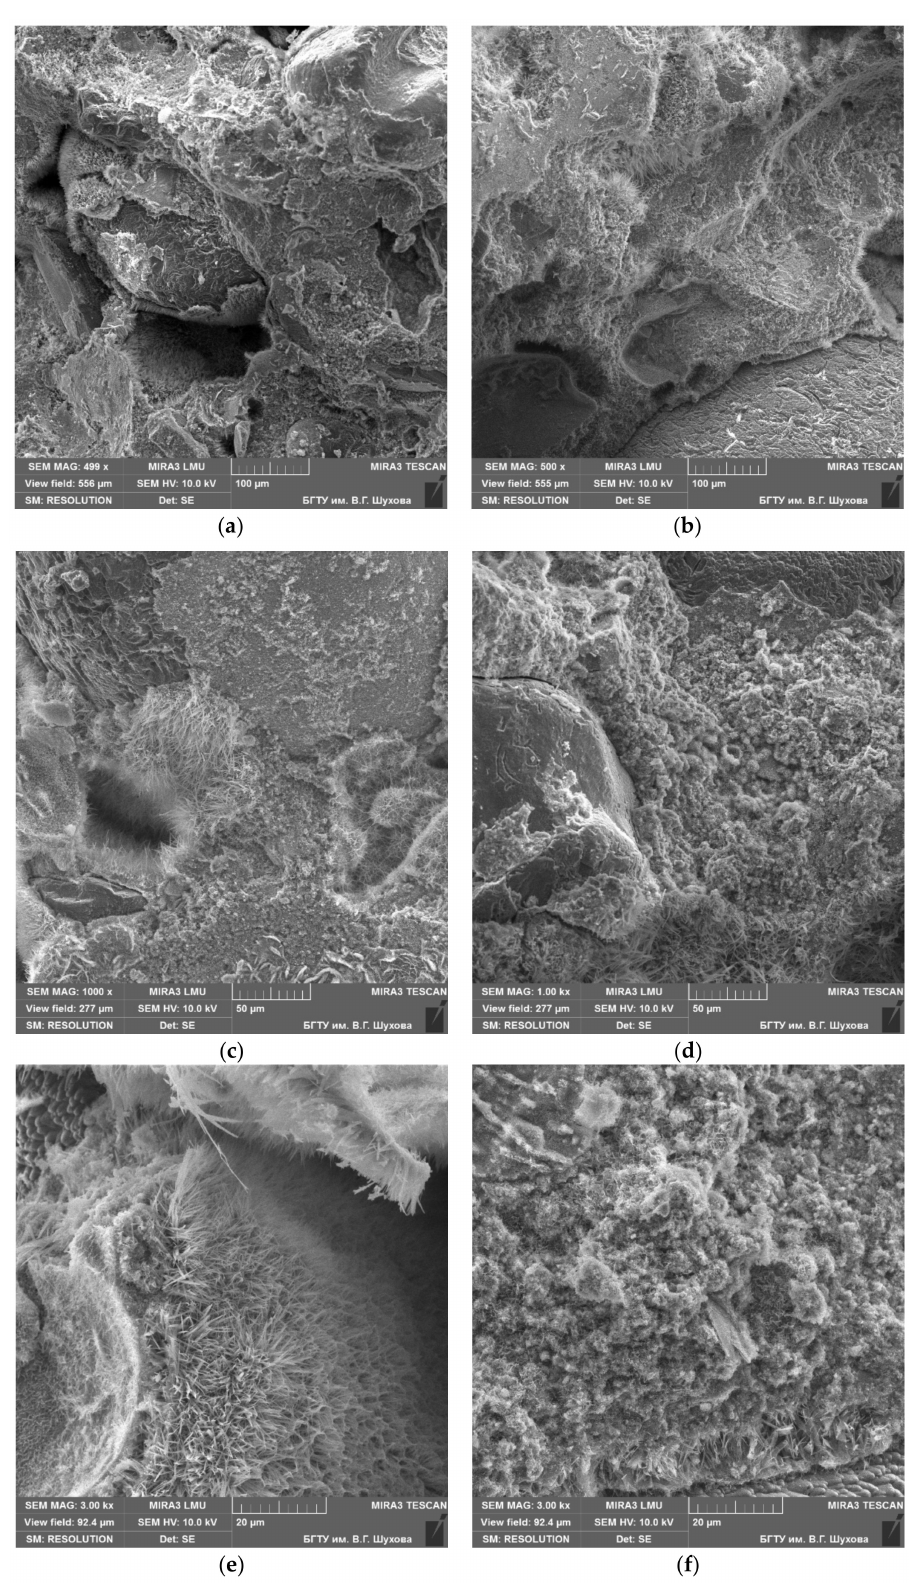
Figure 17. Microstructure of specimens depending on composition: ( a , c , e ) control; ( b , d , f ) experimental with 15%